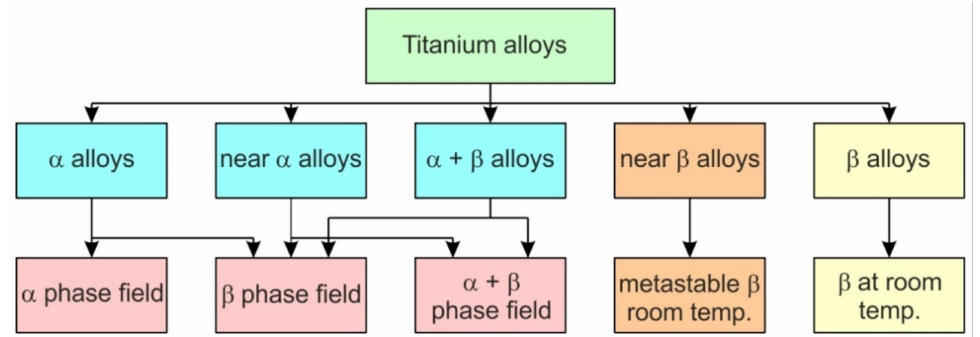
Figure 1. Classification of titanium-based